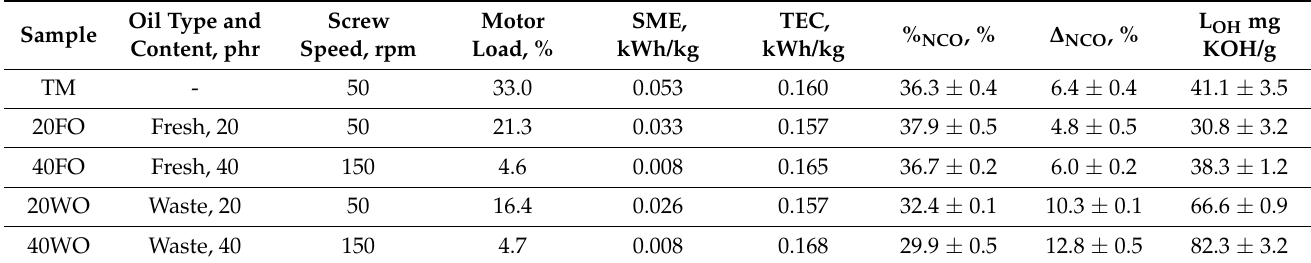
Table 2. The properties of GTR samples applied in the presented